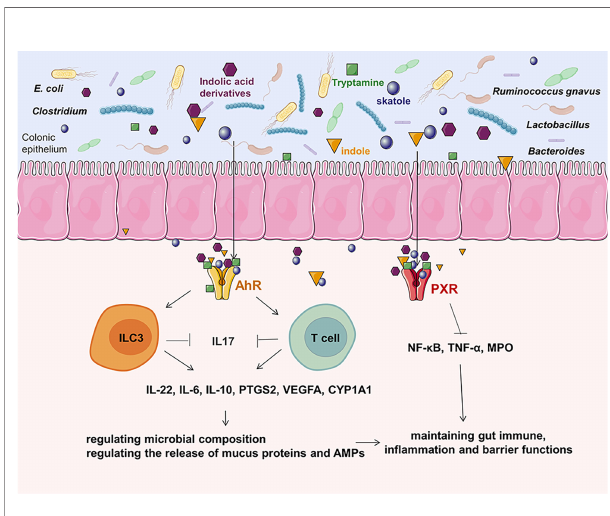
FIGURE 3 | The effects of Trp metabolites onCRC.As one of the mostpotent bioactive metabolites, bacterial Trp metabolites can activatethe cytosolic ligand- activated transcription factorAhR andPXR, which can in fl uence the release of cytokines andmodulate gut immunological, in fl ammation,and barrier functions. ILC3, innate lymphoid cell3; VEGFA, vascular endothelial growth factorA; MPO, mucosalmyeloperoxidase; AMP, antimicrobial peptides; PTGS2, prostaglandin G/Hsynthase 2; PXR, pregnane X receptor;CYP1A1, cytochrome P450 1A1; AhR, aryl